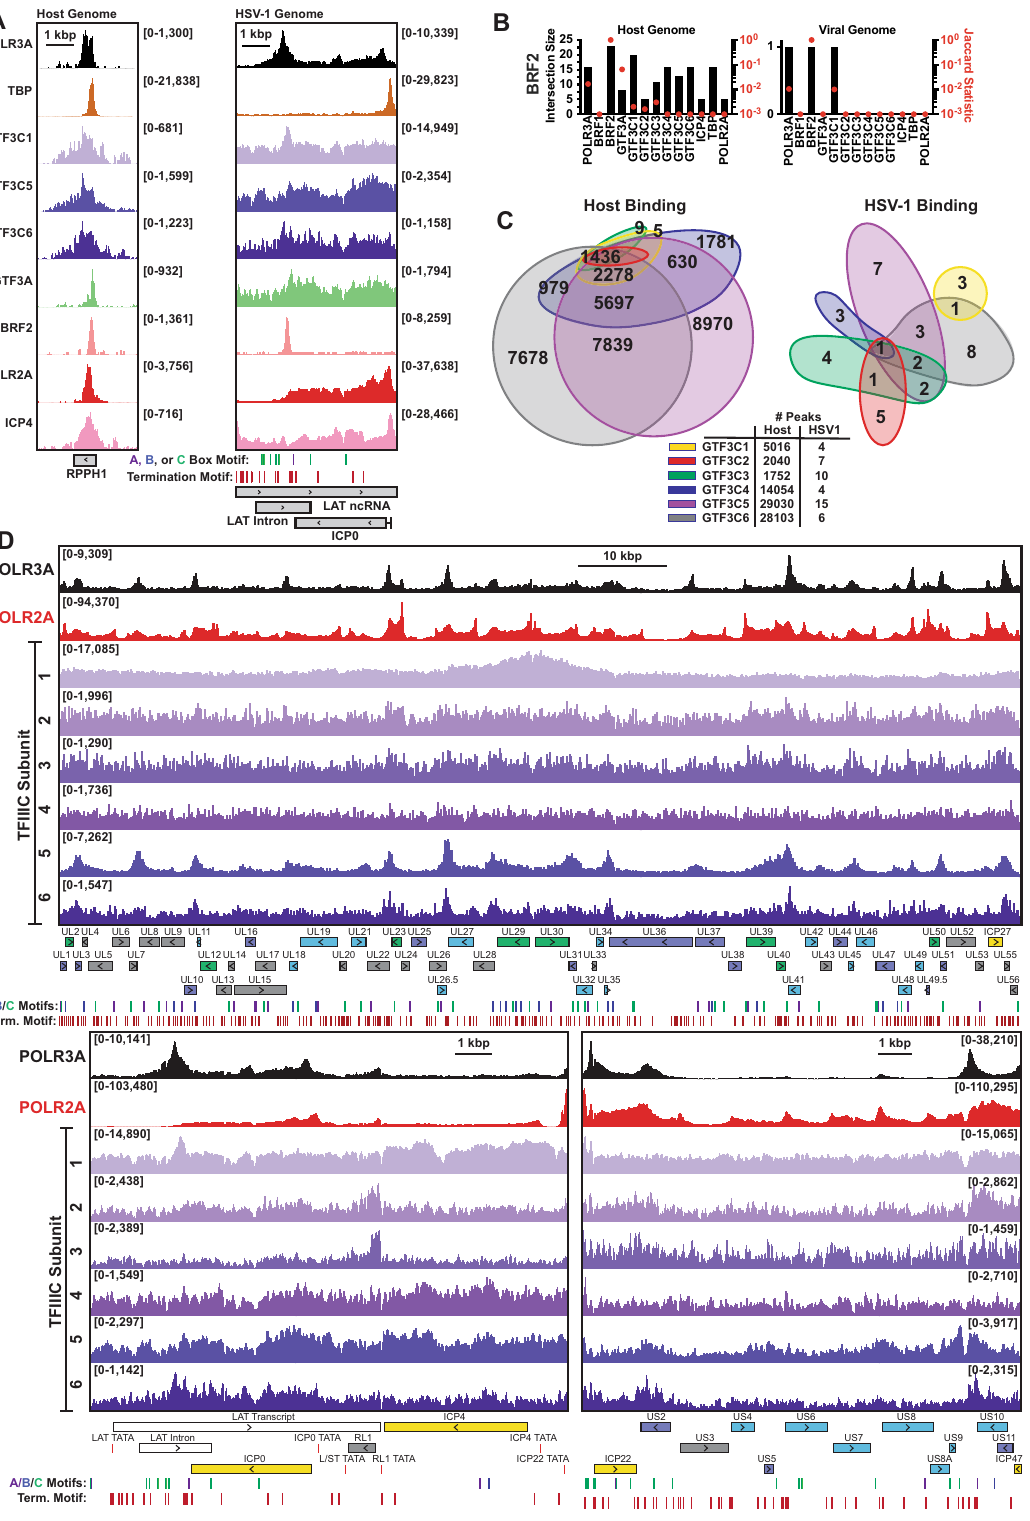
NATURE COMMUNICATIONS| (2022) 13:623